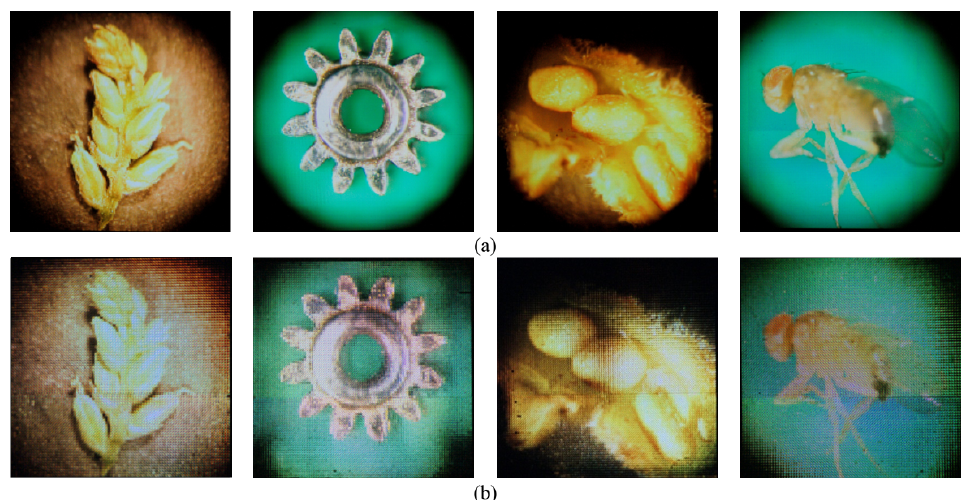
Figure 14. Result of 3D-image capture; ( a ) 3D image using proposed EIA, ( b ) 3D image using original EIA.